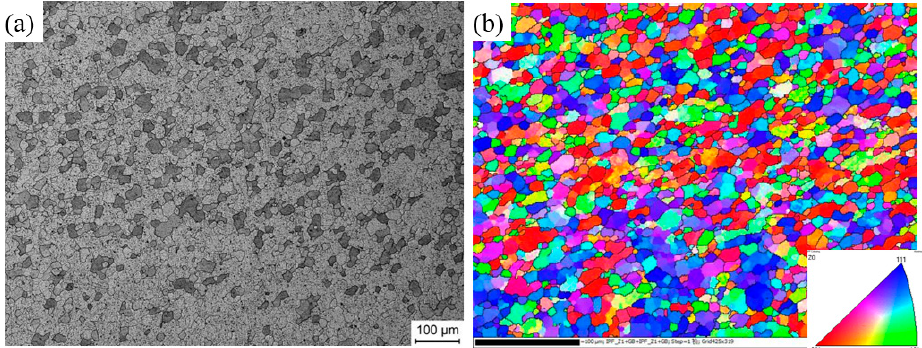
Figure 4. ( a ) Microstructure and ( b ) OIM of SZ of as-welded sample.